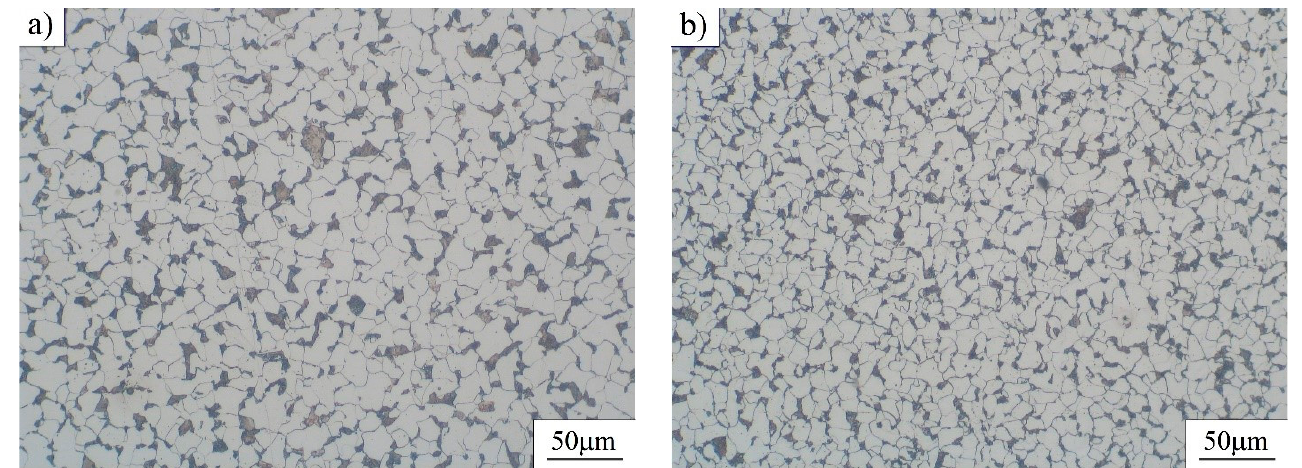
Figure 5. Microstructure of tested steels (as-received materials)—images taken using optical (LM) microscope: ( a ) S235JRC+C steel and ( b ) C15E+C steel